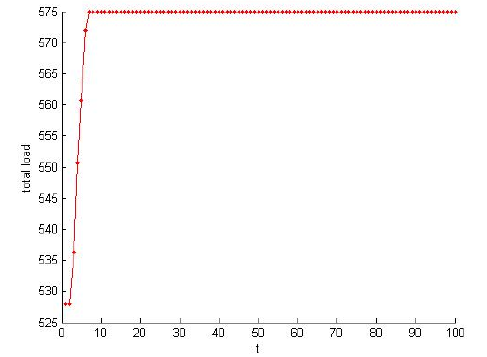
Figure 14. Load increased in the self-organization